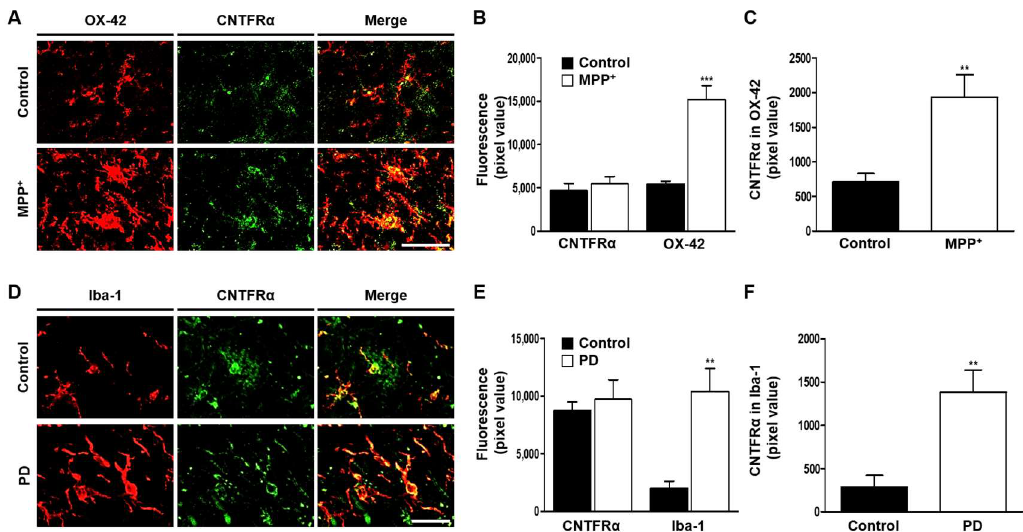
Figure 4. CNTFR α expression on microglia in the SN of the MPP + -lesioned rat and human PD brain. ( A – C ) MPP + was unilaterally injected into the rat MFB and tissues were prepared for immunohistochemical analysis at 1 week post MPP + injection. ( A ) Fluorescence images of CNTFR α (green) or OX-42 (red) and both images are merged in the rat SN 1 week post MPP + injection into rat MFB. Quantification of CNTFR α expression and OX-42 + cells (B), and CNTFR α expression in OX-42 + cells ( C ). Student t -Test analysis, ** p < 0.01 ( t OX-42 = 3.513, df = 8), *** p < 0.001 ( t CNTFR α in OX-42 = 6.115, df = 8) significantly different from control. ( D – F ) CNTFR α expression in the SN of human PD brain. ( D ) Fluorescence images of CNTFR α (green) and Iba-1 + microglia (red) and both images are merged. Quantification of CNTFR α or Iba-1 + microglia ( E ), and CNTFR α expression in Iba-1 + microglia ( F ). Student t -Test analysis, ** p < 0.01 ( t Iba-1 = 3.971, df = 4), ** p < 0.01 ( t CNTFR α in Iba-1 = 3.785, df = 4), significantly different from control. Scale bars; 50 µ m ( A ), 20 µ m ( D ). Mean ± S.E.M; ( B , C ) n = 5; ( E , F ) n = 3.